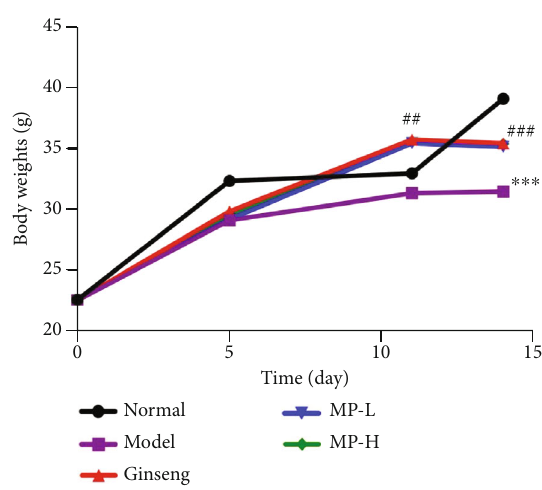
Figure 3: Indices of spleen and thymus ( n = 12 ). Notes: ∗∗∗ p <